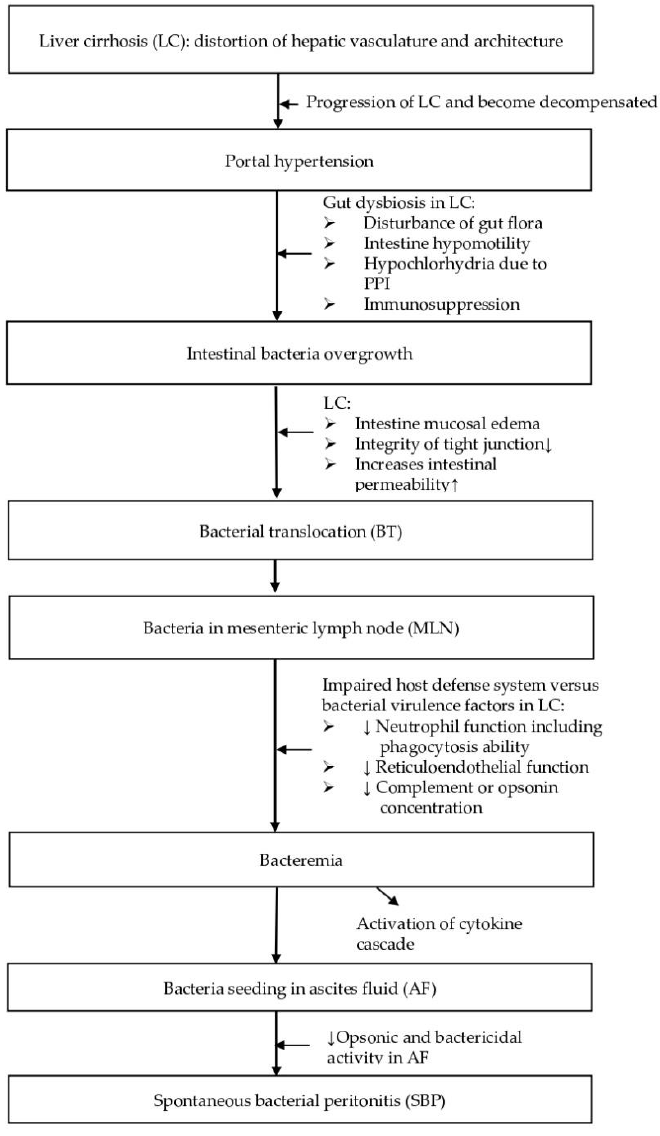
Figure 1. Mechanisms involved in the pathogenesis of